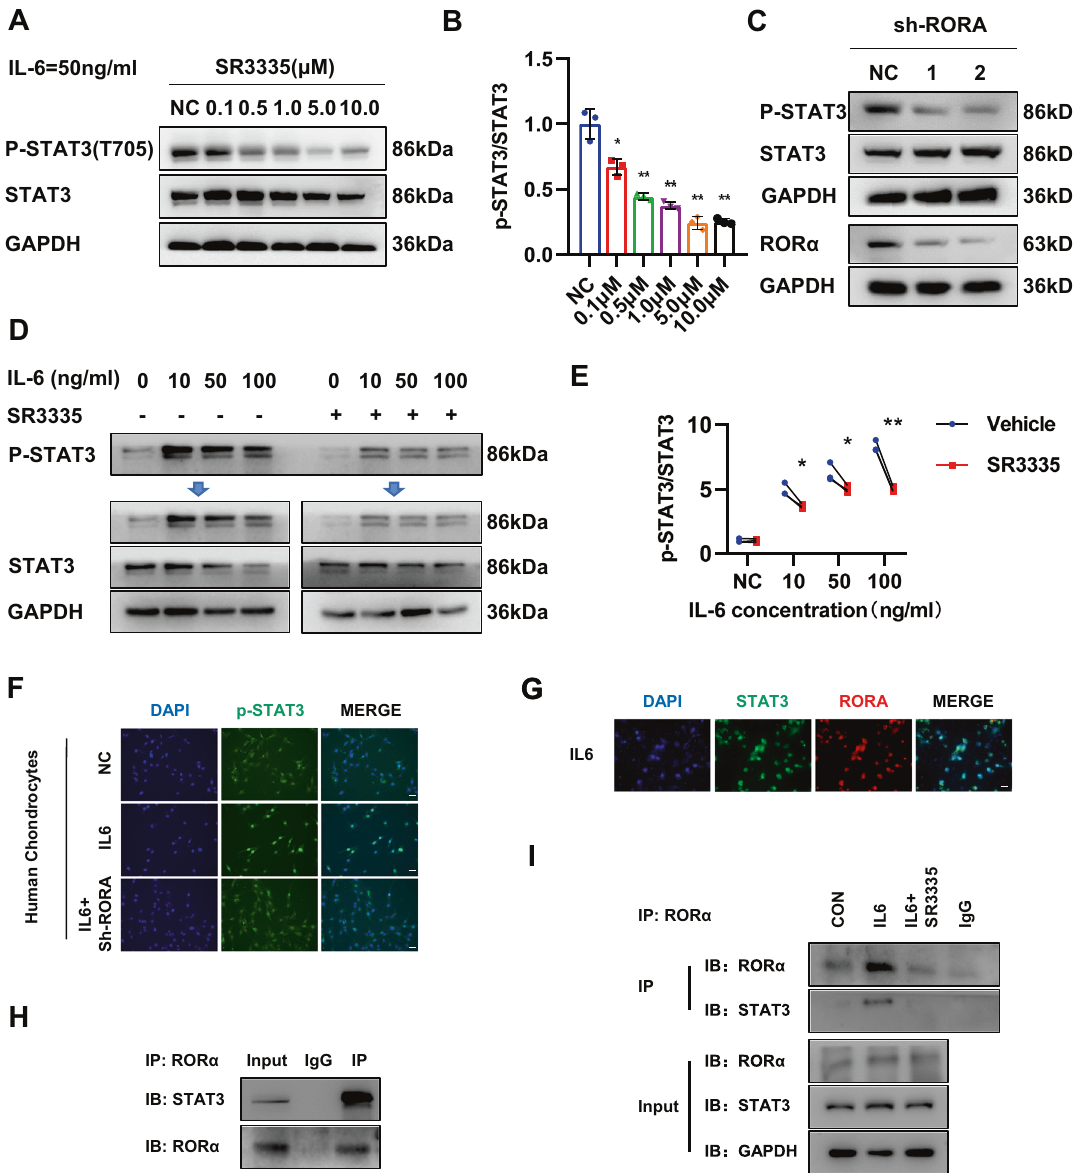
Fig. 6 ROR α regulates STAT3 phosphorylation via binding with STAT3. A , B The expression of STAT3 and phosphorylated STAT3 (Y705) in human articular chondrocytes after pretreated with a gradient concentration of SR3335 for 6 h and a 50 ng/ml IL-6 treatment for 30 min was detected by Western blot. Quanti fi cation was conducted and the ratio of p-STAT3/STAT3 was calculated. C The expression of STAT3 and phosphorylated STAT3 (Y705) in human articular chondrocytes after sh-RORA infection for 72 h and IL-6 treatment for 30 min were detected by western blot. D , E The expression level and quanti fi cation of phosphorylated STAT3 (Y705) in isolated human articular chondrocytes after pretreated with 1 μ M SR3335 for 6 h and then treated with a gradient concentration of IL-6 for 30 min. F The chondrocytes were infected with sh-RORA or sh-NC lentivirus for 72 h and treated with IL-6 (50 ng/ml) for 30 min. Slices were harvested after indicated treatment and subjected to fl uorescence microscopy of p-STAT3/DAPI staining in formaldehyde- fi xed cells. Scale bar = 50 μ m. G Slices of human chondrocytes were harvested after indicated treatment and subjected to fl uorescence microscopy of ROR α , STAT3, and DAPI staining in formaldehyde- fi xed cells. Scale bar = 50 μ m. H Immunoprecipitation was performed on chondrocytes after IL-6 treatment for 1 h with anti-ROR α antibody. I Immunoprecipitation was performed with anti-ROR α antibody after treatment with vehicle, 50 ng/ml IL-6, or 50 ng/ml IL-6, and 1 μ M SR3335 for 1 h. Representative blots and images ( n = 3). The statistical data in E were analyzed with Student ’ s t test, and data in B were analyzed with one-way ANOVA followed by Dunnett ’ s test. * P < 0.05, ** P < 0.01, ns = no signi fi cance. All data shown above are presented as mean ±